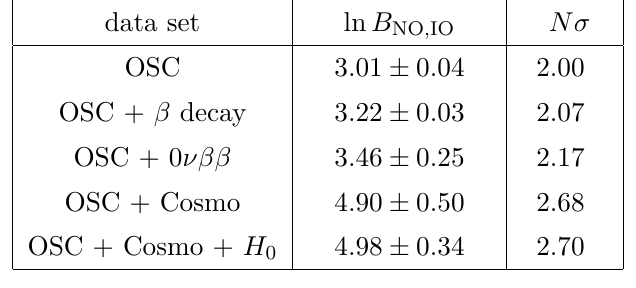
Table 2 . Bayes factors and significance in terms of standard errors of normal versus inverted mass ordering for various data